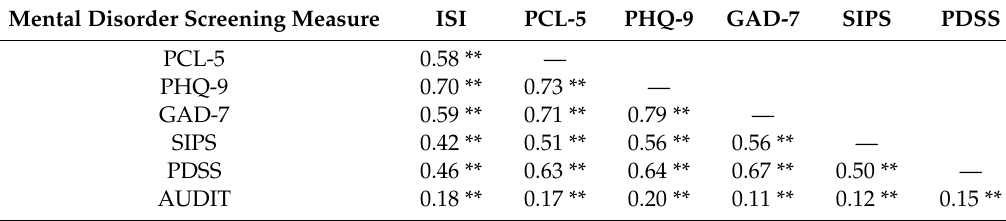
Table 5. Correlations between Insomnia and Mental Disorder Screening Measures Across all PSP. Mental Disorder Screening Measure ISI PCL-5 PHQ-9